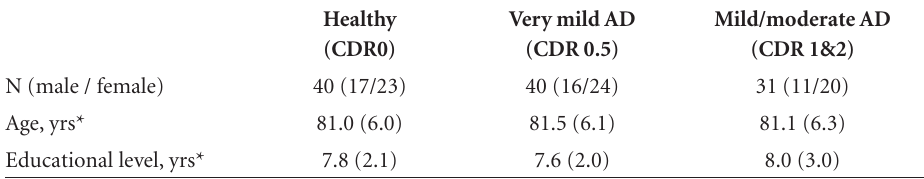
Table 1. Demographics of the study